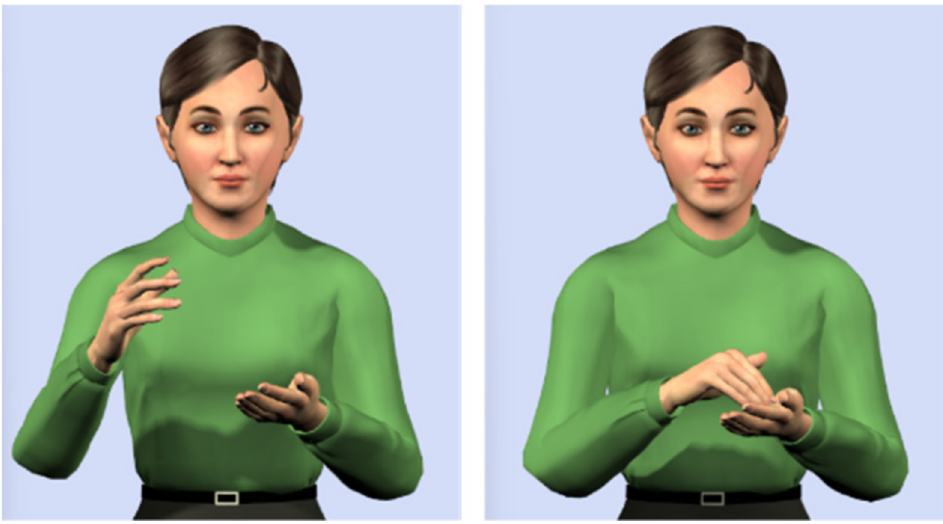
Figure 7. Two key frames define the sign AGAIN